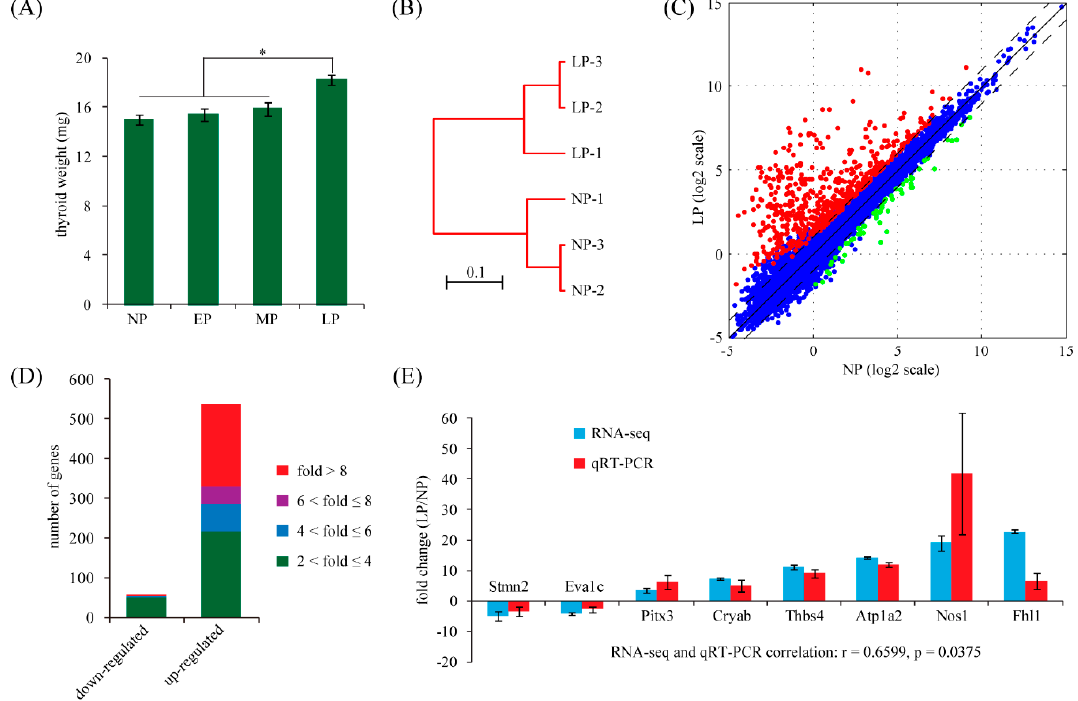
Figure 1. Identification of differentially expressed genes in maternal thyroid in late pregnancy. ( A ) Maternal thyroid weight responses to pregnancy in rats. Thyroid tissues were collected from non-pregnant (NP) and pregnant rats on Days 8 (early pregnancy, EP), 12 (middle pregnancy, MP) and 18 (late pregnancy, LP) of pregnancy. Absolute thyroid weight is used. Each bar represents at least three animals. * p < 0.05; ( B ) Cluster dendrogram of RNA-seq data generated from six samples. The Pearson correlation distance measure and the average linkage clustering algorithm were used. The plot was generated by using bioinformatics toolbox 3.3 of MATLAB (MathWorks); ( C ) Scatter plot depicting the expression profiles of all genes. FPKM values from RNA-Seq are plotted in log2 scale. Dash lines indicate the two-fold difference boundaries. Non-changed genes were shown in blue color, while differently expressed genes (fold change > 2 and adjusted p < 0.05) were denoted in red or green; ( D ) Distribution of fold change values among down-regulated and up-regulated genes; ( E ) Validation of selected genes identified by RNA-Seq using qRT-PCR. Fold-change values determined by both RNA-seq and qRT-PCR were presented as the mean ± SD. Statistical significance was reached at p < 0.05 for all genes. Stmn2, stathmin 2; Eva1c, eva-1 homolog C; Pitx3, paired-like homeodomain 3; Cryab, crystallin α B; Thbs4, thrombospondin 4; Atp1a2, ATPase Na + /K + transporting α 2 polypeptide; Nos1, nitric oxide synthase 1 neuronal; Fhl1, four and a half LIM domains 1.